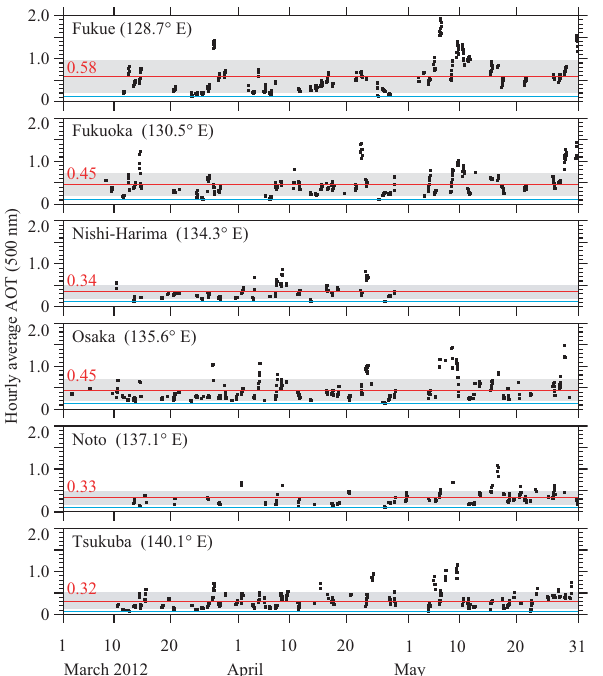
Figure 4. Site deployment during DRAGON-Osaka in spring 2012. Colored lines indicate the path of transect